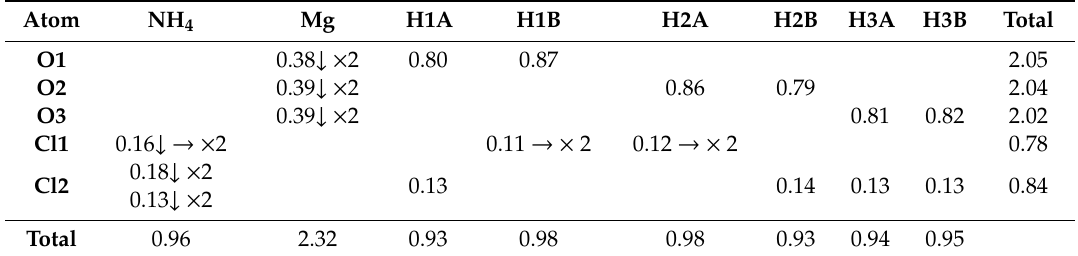
Table 10. Bond-valence analysis (v.u. = valence units) for NH 4 MgCl 3 · 6H 2 O